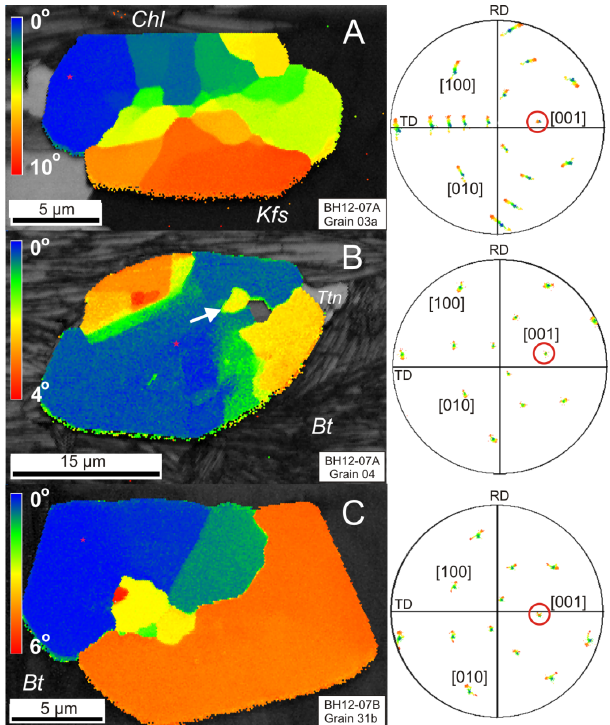
Figure 9. (Sub)grain shape and crystallographic orientation of zir- con from sample BH12-07 (basic dyke). Left-hand side – EBSD maps colored for misorientation with respect to a single reference point (red star marker); right-hand side – pole figure plots showing zircon crystal directions (lower-hemisphere equal area projection) colored as in the corresponding EBSD map. Rotation axes paral- lel to zircon [001] axis are highlighted by a red circle. (a) Grain BH12-07A_03a, lattice distortion type (III) cases 2 and 4. (b) Grain BH12-07A_04, lattice distortion type (III) cases 1, 2, and 3. Ar- row highlights subgrain adjacent to the mineral inclusion. (c) Grain BH12-07B_31B, lattice distortion type (III) case 2. Bt: biotite; Chl: chlorite; Kfs: K-feldspar; Ttn: titanite. NB: the thin sections were cut normal to the foliation plane and at an angle of 50 ◦ with re- spect to the intersection lineation so that the zircon [001] direction coincides with the intersection lineation and the fold